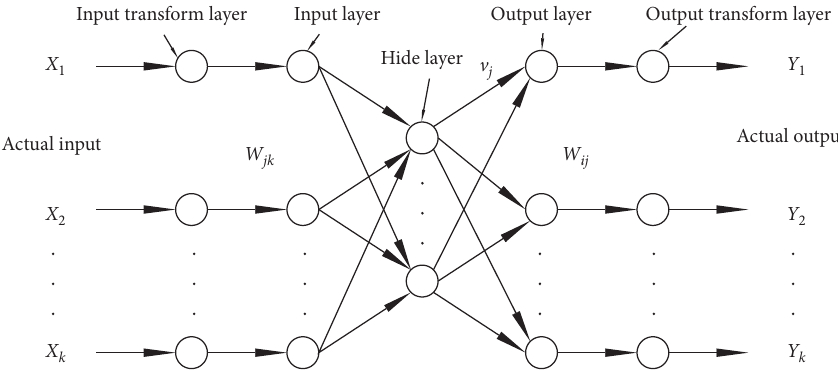
Figure 7: Schematic diagram of three-layer neural network transmission.